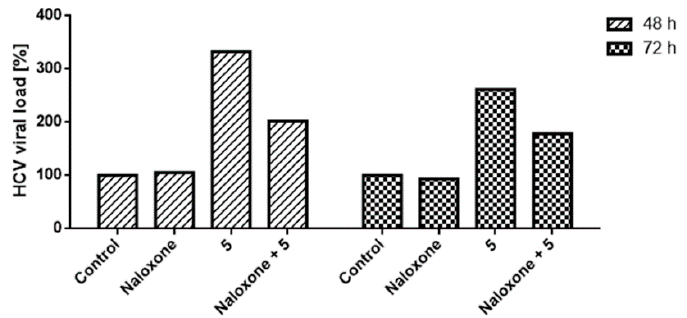
Figure 7. Effect of naloxone (0.01 µM), compound 5 (25.00 µM), and the combination of both on the viral load of HCV in the Huh7.5 SG cells at 48 and 72 h.